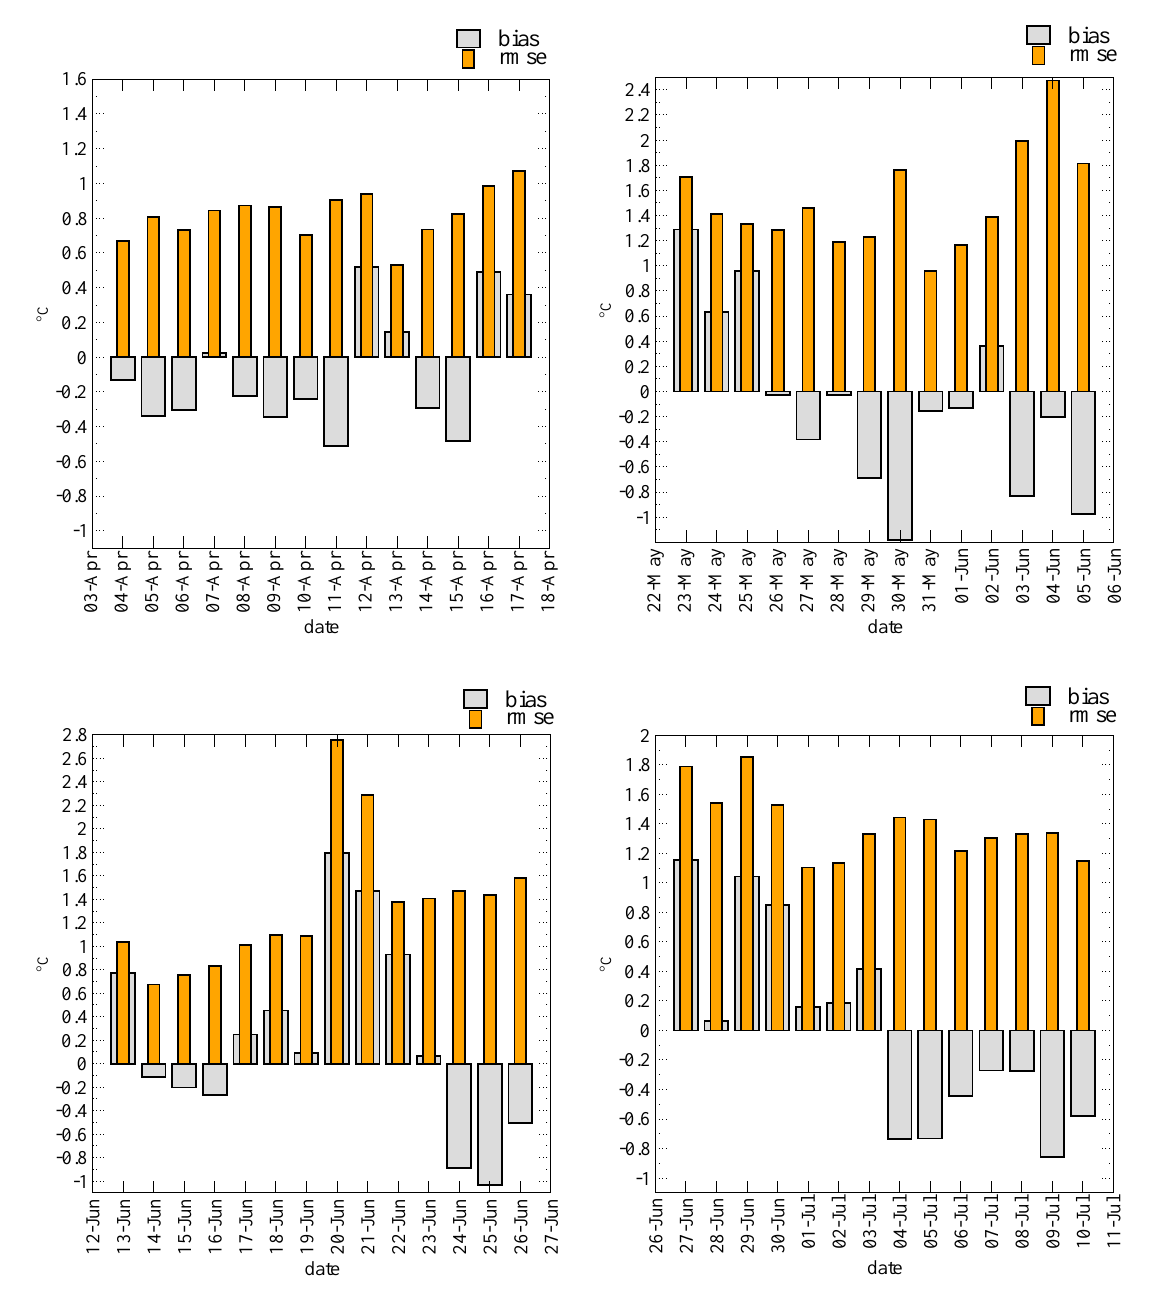
Fig. 7. BIAS and RMSE scores for eight forecasting periods, 3–18 April, 22 May–6 June, 12–26 June and 27 June–11 July, grouped in sets of